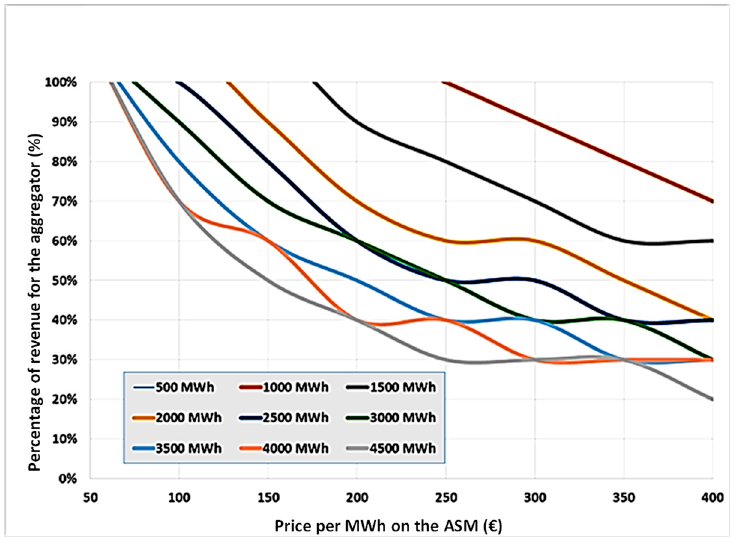
Figure 9. Profit areas according to the costs related to communication (EMP costs = 0 and COM costs = 50) .